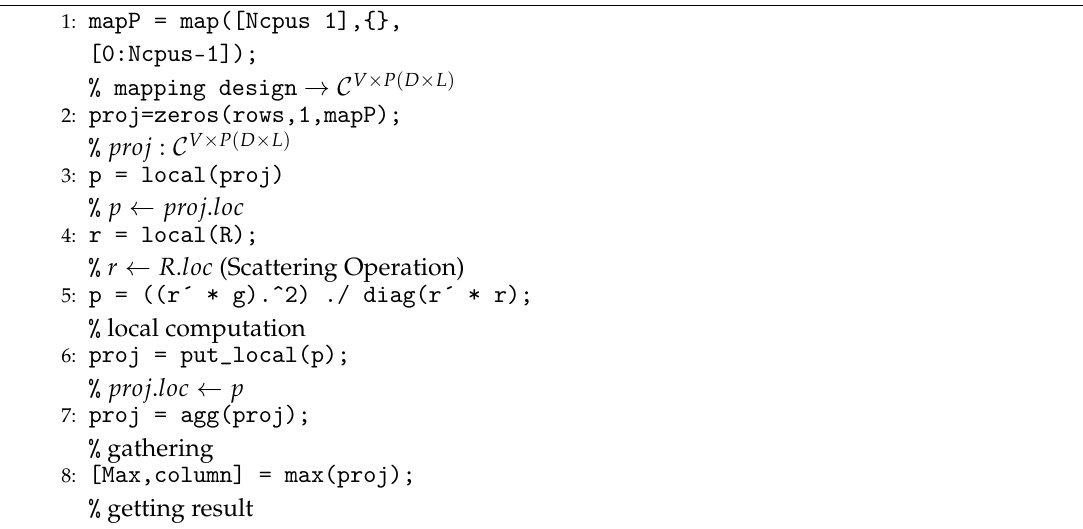
Algorithm 1: Matching pursuit algorithmic core. Distributed max projection.